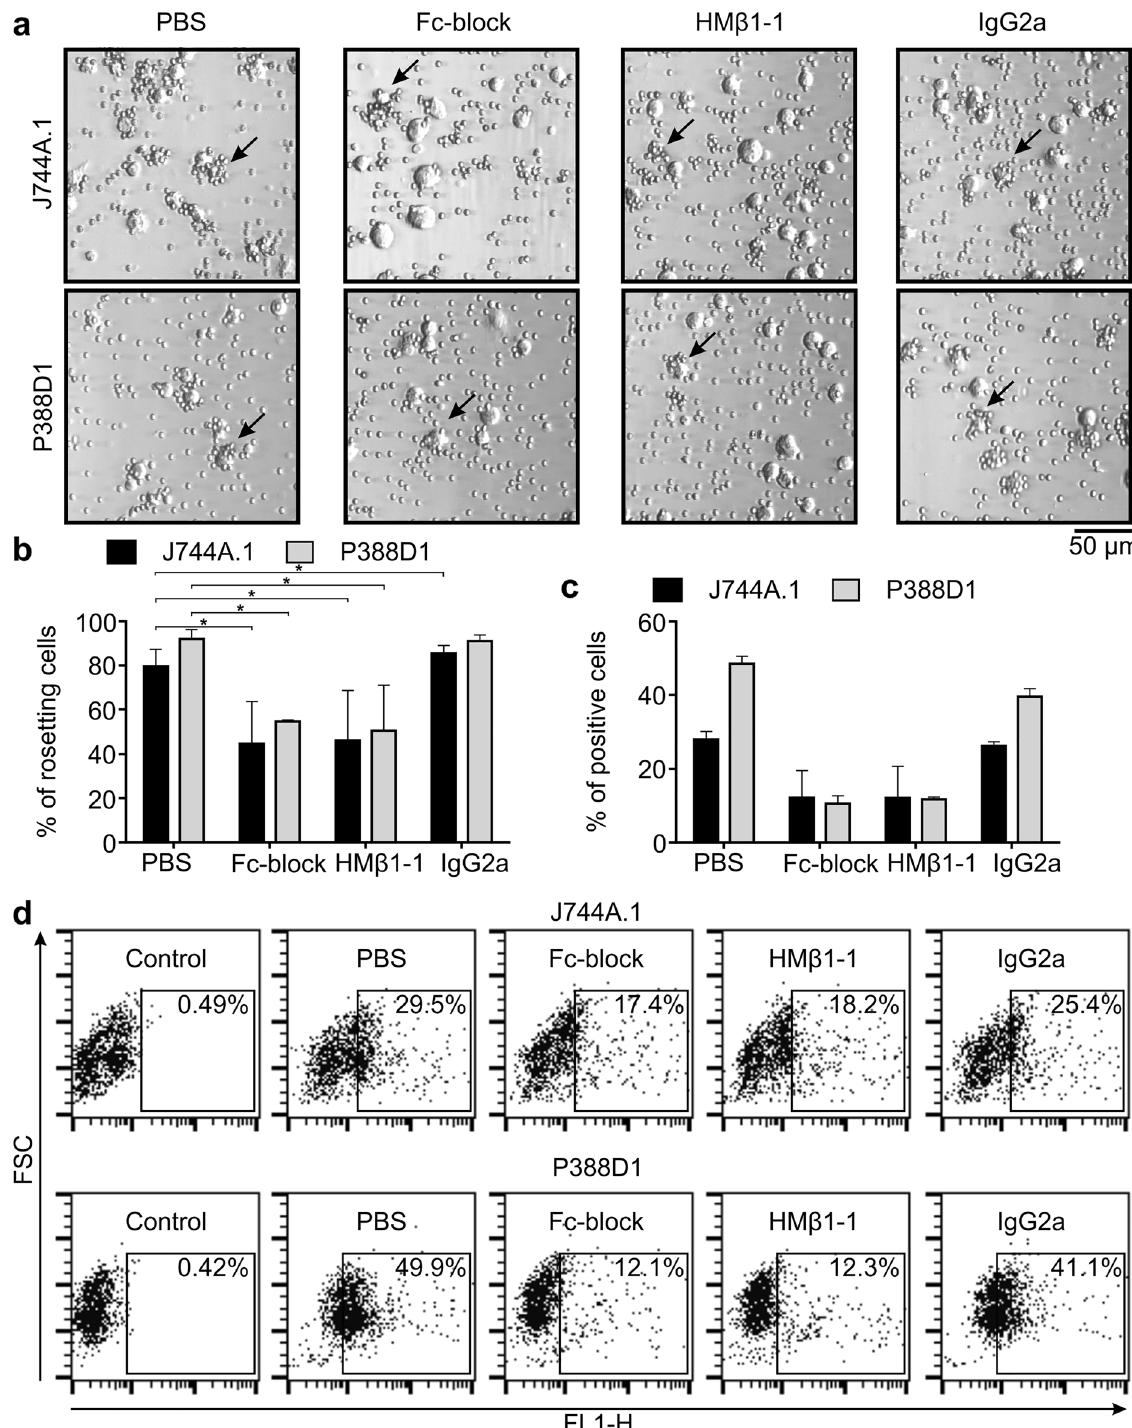
Figure 3. Binding of mIgG3 to J774A.1 or P388D1 cells in the presence of antibodies blocking the putative receptors of mIgG3. Fc-block inhibits binding to FcγRII and FcγRIII, HMβ1-1 blocks ITGB1, and IgG2a is a competitor for IgG binding to FcγRI and FcγRIV. ( a , b ) Rosetting of erythrocytes around J774A.1 and P388D1 cells coated with mIgG3 M18, which binds antigen B of the ABO blood group system. The cells were pre-incubated with the blocking antibodies, then coated with M18 mIgG3 and analyzed in the rosetting assay. ( a ) Representative microscope images of two independent rosetting experiments are shown. Exemplary rosettes are indicated with arrows. ( b ) Average values ± SD from two independent rosetting experiments are shown. Three randomly chosen fields were analyzed for each sample in each experiment, *p < 0.001. ( c , d ) Flow cytometry analysis of M18-488 binding to J774A.1 or P388D1 cells. The cells were pre-incubated with the blocking antibodies and then stained with M18-488 in the presence of the blocking antibodies. ( c ) Average values ± SD from two independent experiments are shown. The same chart extended with results for pairs of the blockers is presented in Supplementary Fig. S14. ( d ) Representative dot plots from the cytometry analysis. ( a – d ) The clone #12 of P388D1 was used in these